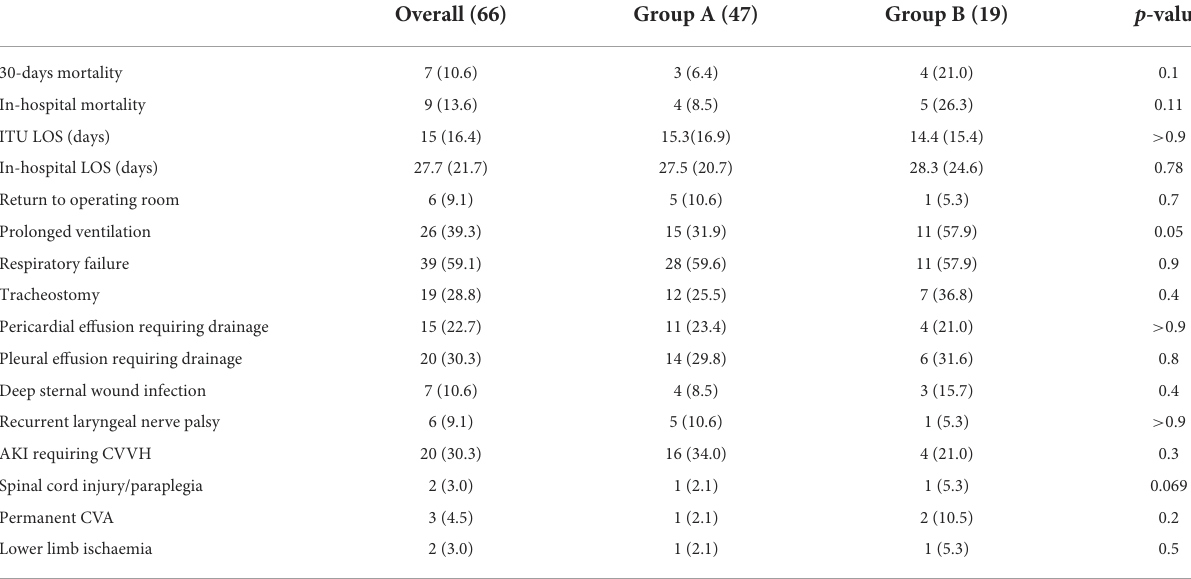
TABLE 3 Post-operative